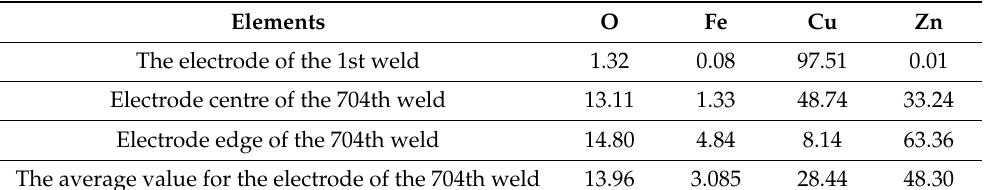
Figure 14. SEM-EDS measurements of the elements on the electrode surface: ( a – d ) the 1st weld; ( e – h ) the 704th weld. Table 4. The element distributions on the surface of the electrode.